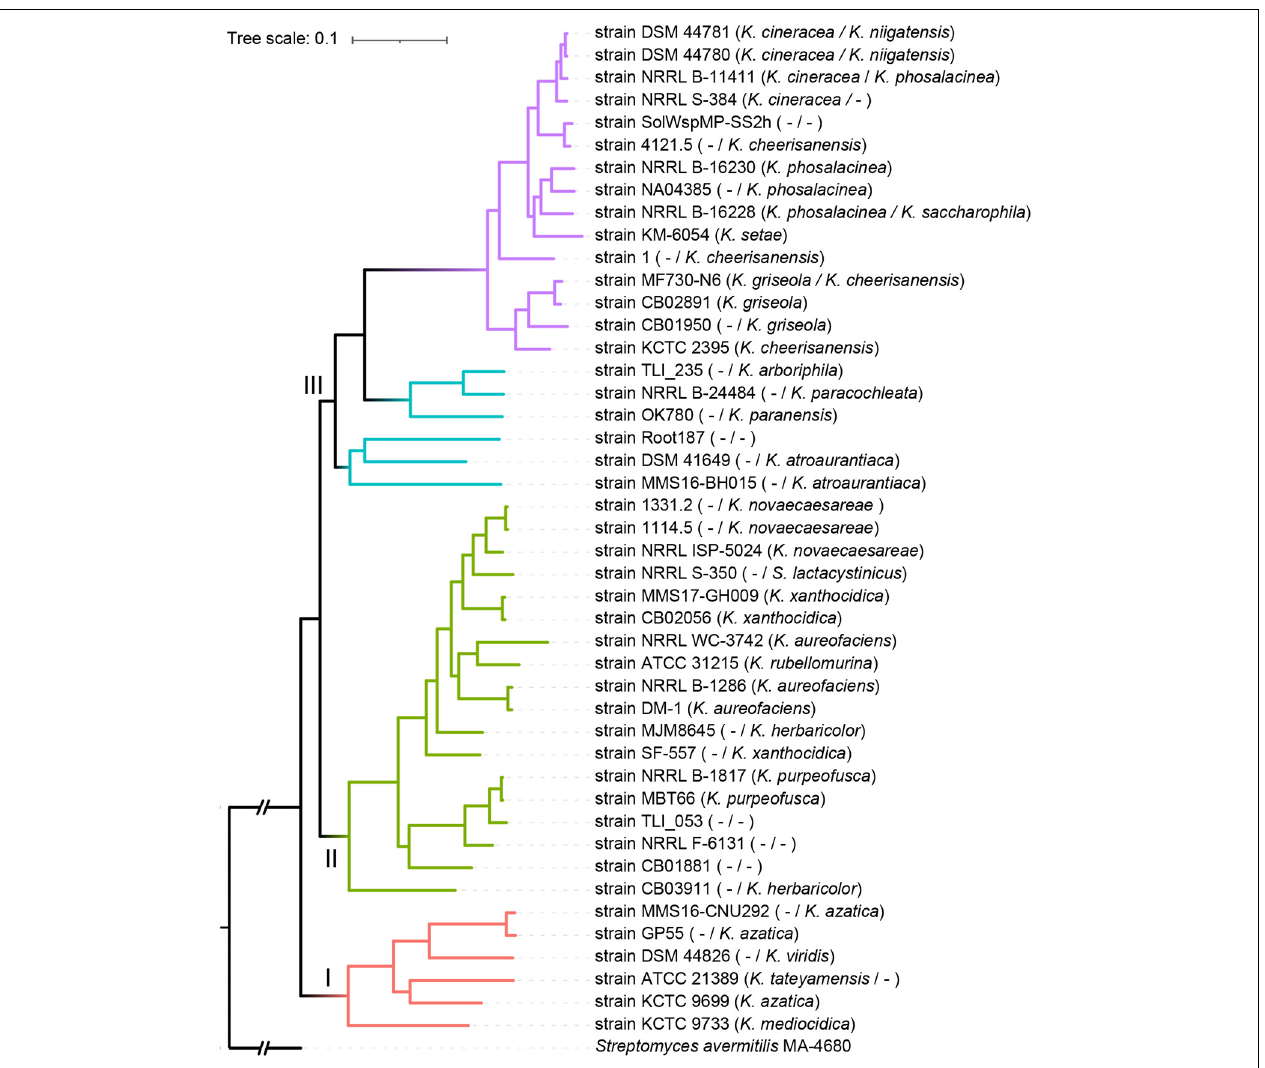
FIGURE 4 | Maximum-likelihood phylogenomic tree of the genus Kitasatospora . The tree was constructed based on 456 core genes that could give a well-resolved tree topology and that did not show signs of recombination. Four major lineages were presented by different branch colors (red, Lineage I; green, Lineage II; cyan, Lineage III; purple, Lineage IV). Taxonomy of each strain derived from GTDB and 16S rRNA gene was indicated on left and right of the slash in the bracket, respectively (if consistent, only one was shown). “I,” “II,” or “III” indicates genetic clades. All nodes have 100% bootstrap support. The scale bar indicates 10% sequence